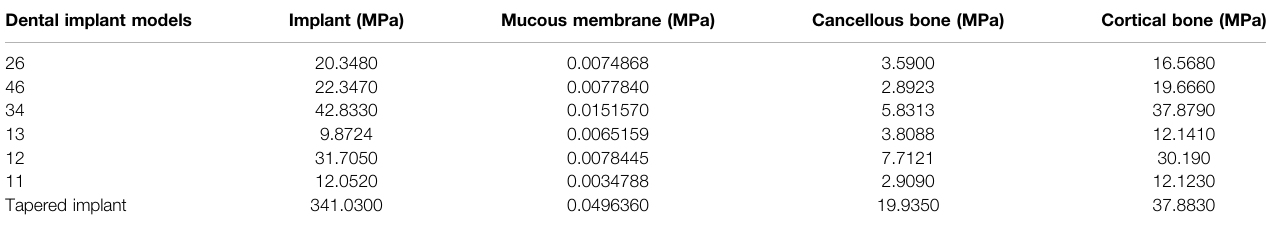
TABLE 4 | Maximum stress values when RAIs and tapered implant are subjected to 100-N oblique load. Dental implant